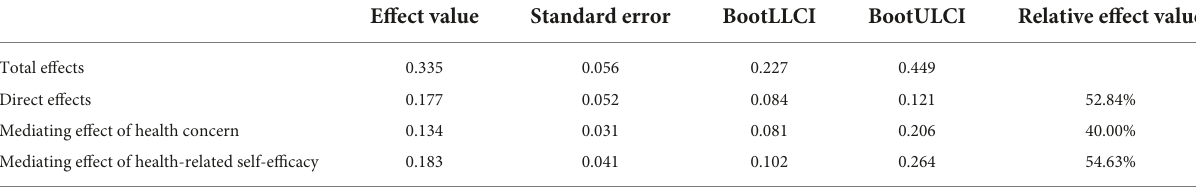
TABLE 7 Decomposition of the total, direct, and mediating effects.